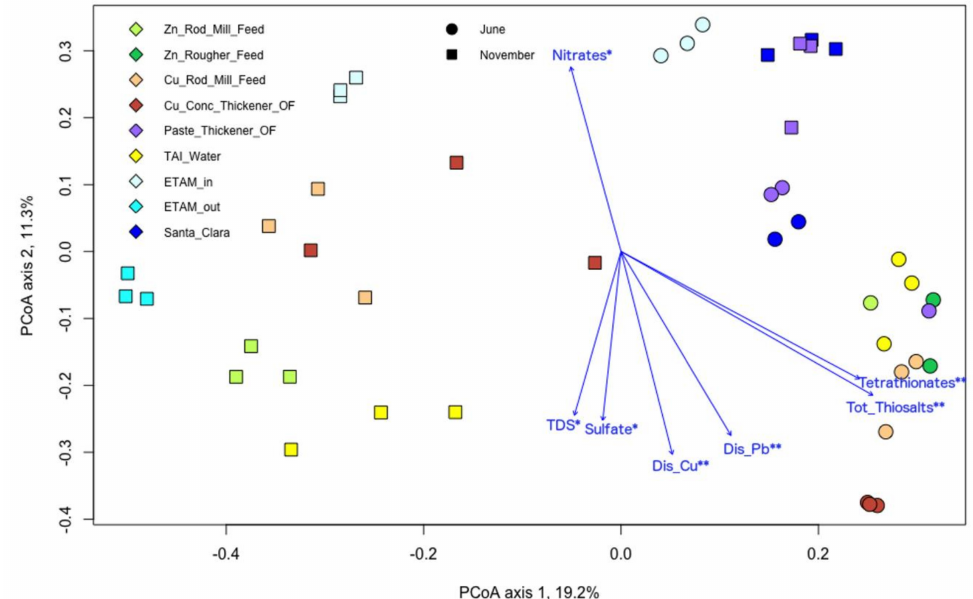
Figure 13. Principal coordinate analysis (PCoA) of the archaeal communities identified from the Portuguese zinc and copper plants and water circuit samples by amplicon sequencing. Statistically significant (* p < 0.01, ** p < 0.001) chemical variables with 9999 permutations are indicated.